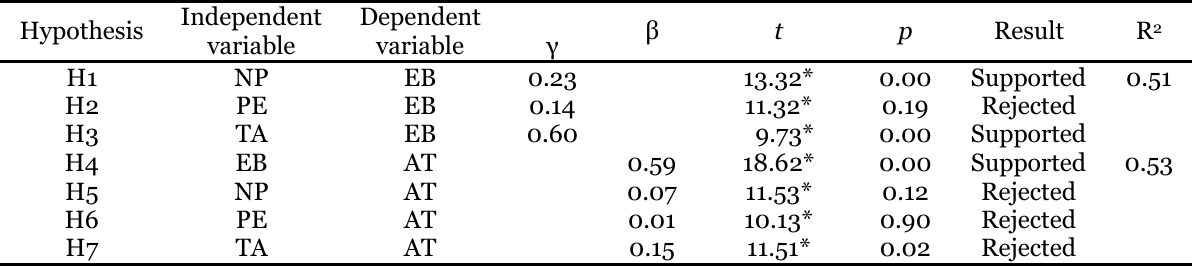
Structural Model Test for Students